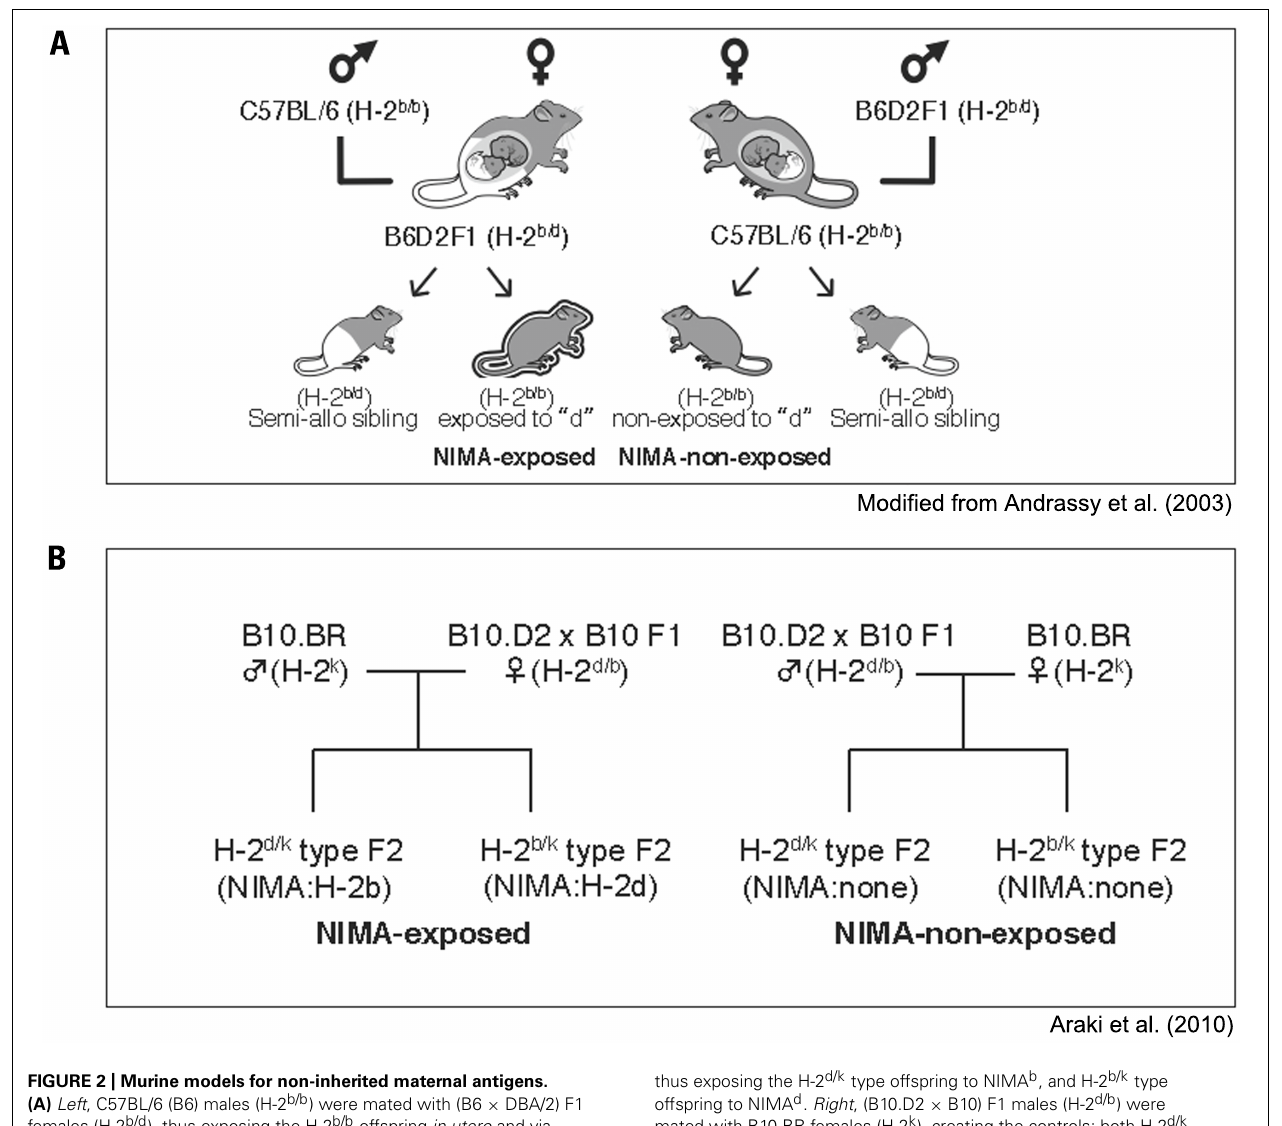
thus exposing the H-2 d/k type offspring to NIMA b , and H-2 b/k type offspring to NIMA d . Right , (B10.D2 × B10) F1 males (H-2 d/b ) were mated with B10.BR females (H-2 k ), creating the controls; both H-2 d/k and H-2 b/k type offspring that had not been exposed to “b” and “d,” respectively.These mice have a B10 background, in other words, their MiHA are matched, and the H-2 antigens are mismatched for both class I and